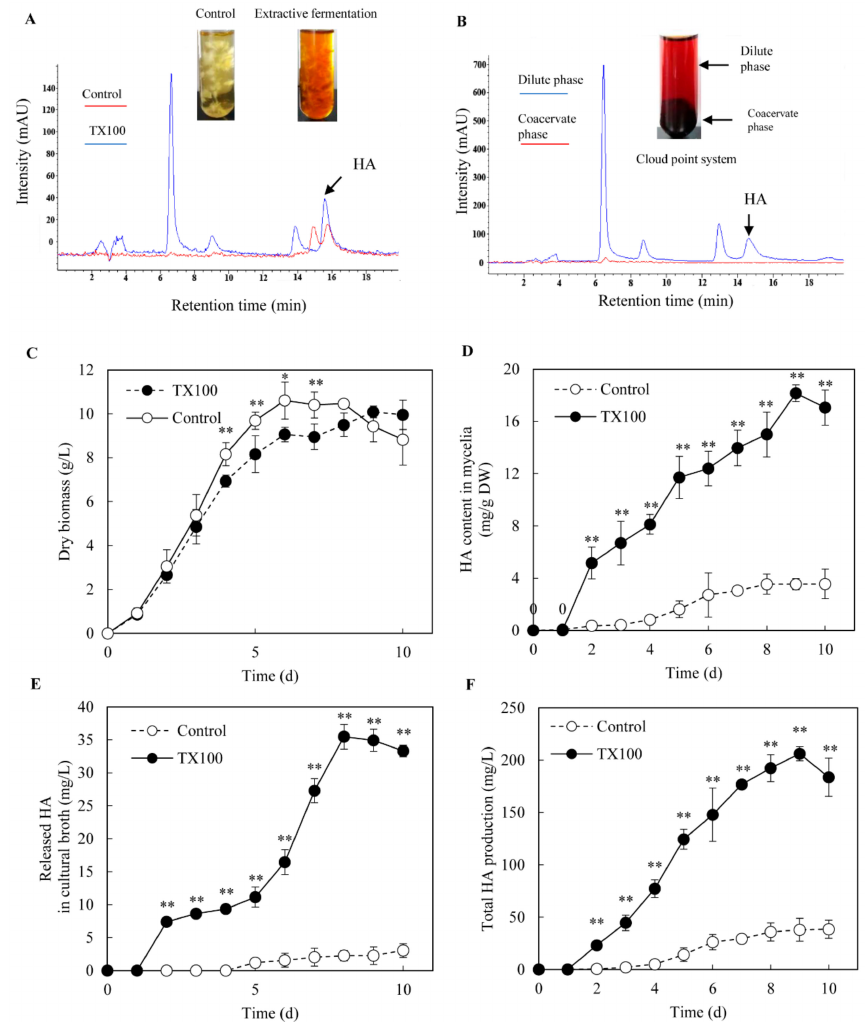
Figure 1. The extractive fermentation of Shiraia sp. S9 in nonionic surfactant micelle aqueous solution. ( A ) The chromatogram of HA in Shiraia mycelia in the extractive fermentation. ( B ) The chromatogram of HA in cloud point system. TX100 was added at (25 g / L) at 36 h of 8-day fermentation. The supernatant was heated at 75 ◦ C for 1 h and separated into a cloud point system including TX100-rich phase (coacervate phase) and the dilute phase. The time-course of fungal biomass ( C ), HA content in mycelia ( D ), the released HA in cultural broth ( E ) and the total HA production ( F ) in the extractive fermentation. Data shown is the mean ± SD (n = 3). Asterisks represent significant di ff erences when compared to control group, * p < 0.05, ** p <